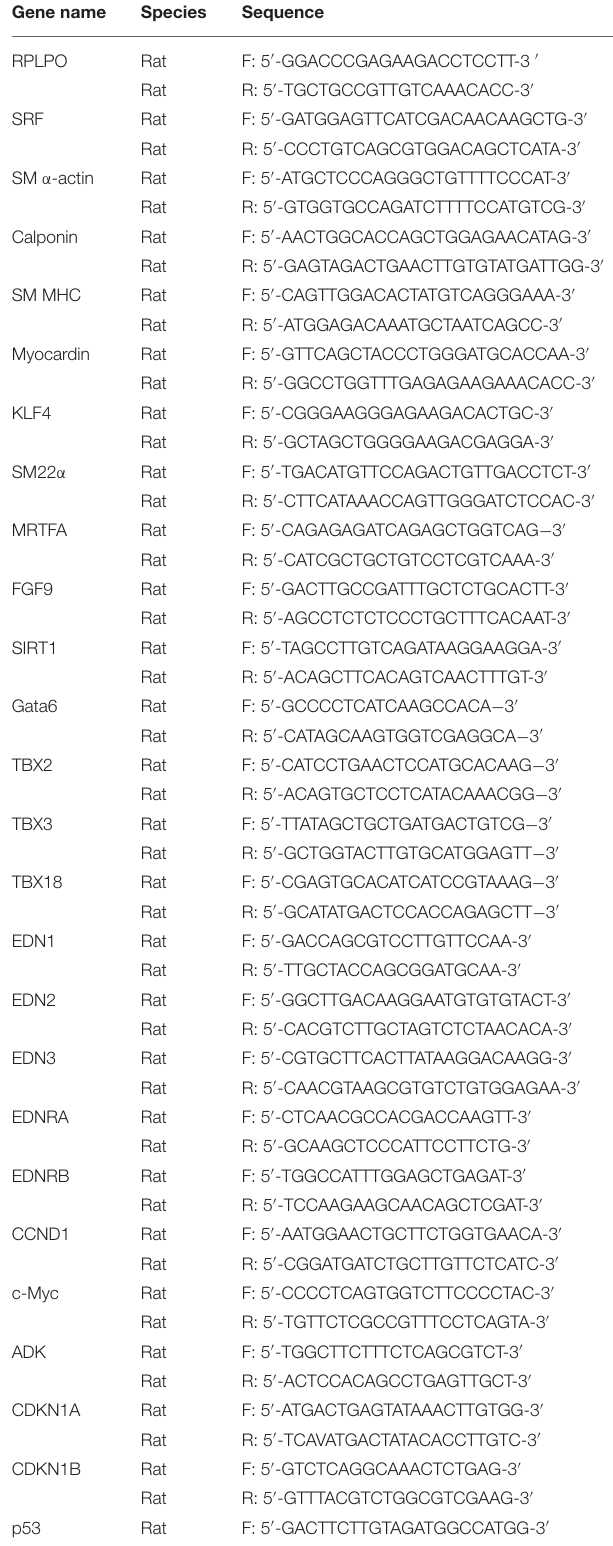
TABLE 1 | List of primer sequences used for real time PCR in the study. Gene